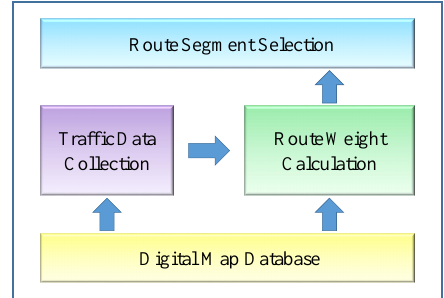
Figure 1. Framework of the route planning